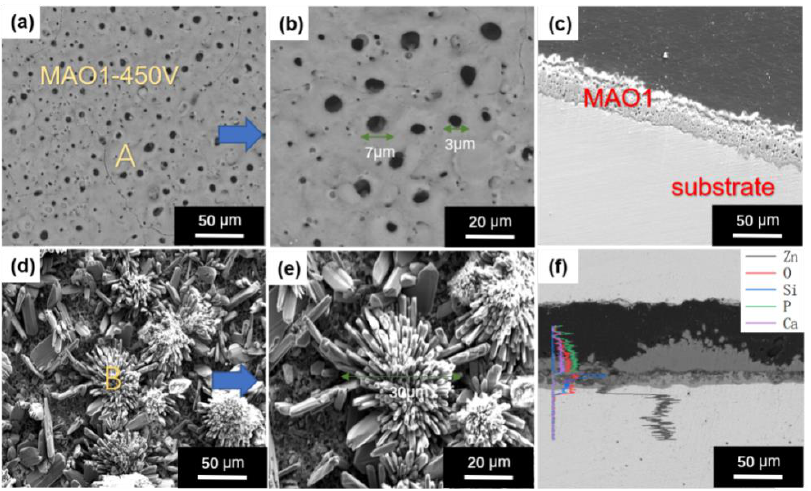
Figure 1. Microstructures of MAO1 and MAO1 − HT coatings: ( a , b ) surface and ( c ) cross-sectional morphologies of MAO1. ( d , e ) surface and ( f ) cross-sectional morphologies of MAO1 −